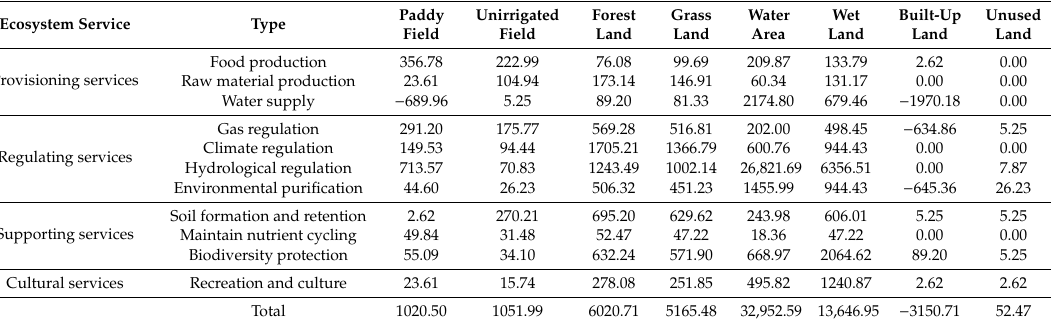
Table 6. ESV coe ffi cients of di ff erent ecological service types for each land use type in Anhui Province (USD / ha /